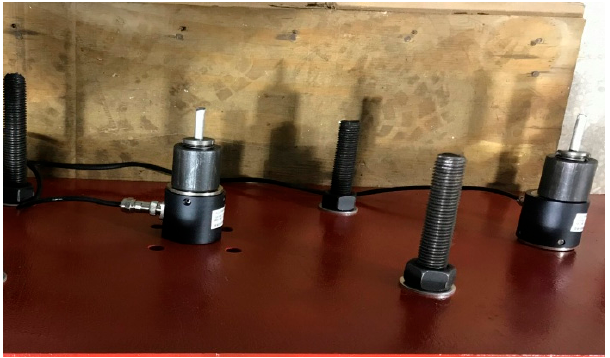
Appl. Sci. 2019 , 9 , x FOR PEER REVIEW Figure 7. Hollow shaft type annular force sensor—JHBH. Figure 7. Hollow shaft type annular force sensor—JHBH.